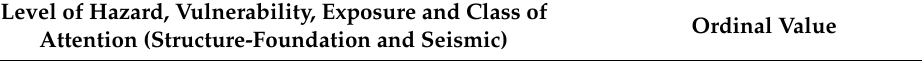
Table 5. Ordinal values assigned to hazard, vulnerability, exposure and class of attention (structure- foundation and